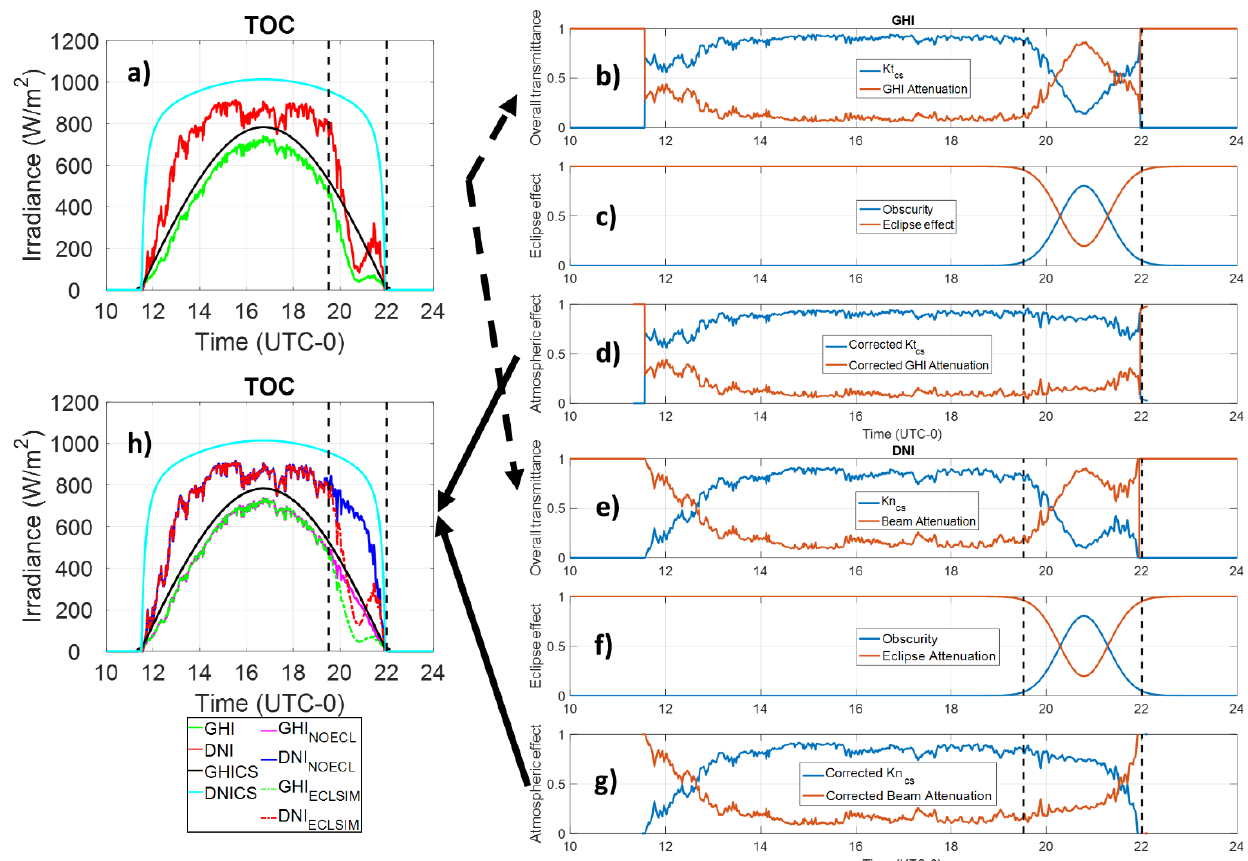
Figure 7. Estimation of atmospheric attenuation and reconstruction of irradiance under no eclipse conditions. Vertical dashed lines mark the beginning and end of the eclipse according to astronomical algorithm. ( a ) Measured and clear sky irradiances, ( b ) clear sky clearness index and GHI attenuation, ( c ) eclipse obscuration as a function of time, ( d ) corrected clear sky clearness index and GHI attenuation to discount eclipse effect, ( e ) clear sky beam transmittance and DNI attenuation, ( f ) eclipse obscuration as a function of time, ( g ) corrected clear sky beam transmittance and DNI attenuation to discount eclipse effect, ( h ) estimation of irradiance discounting eclipse effect.